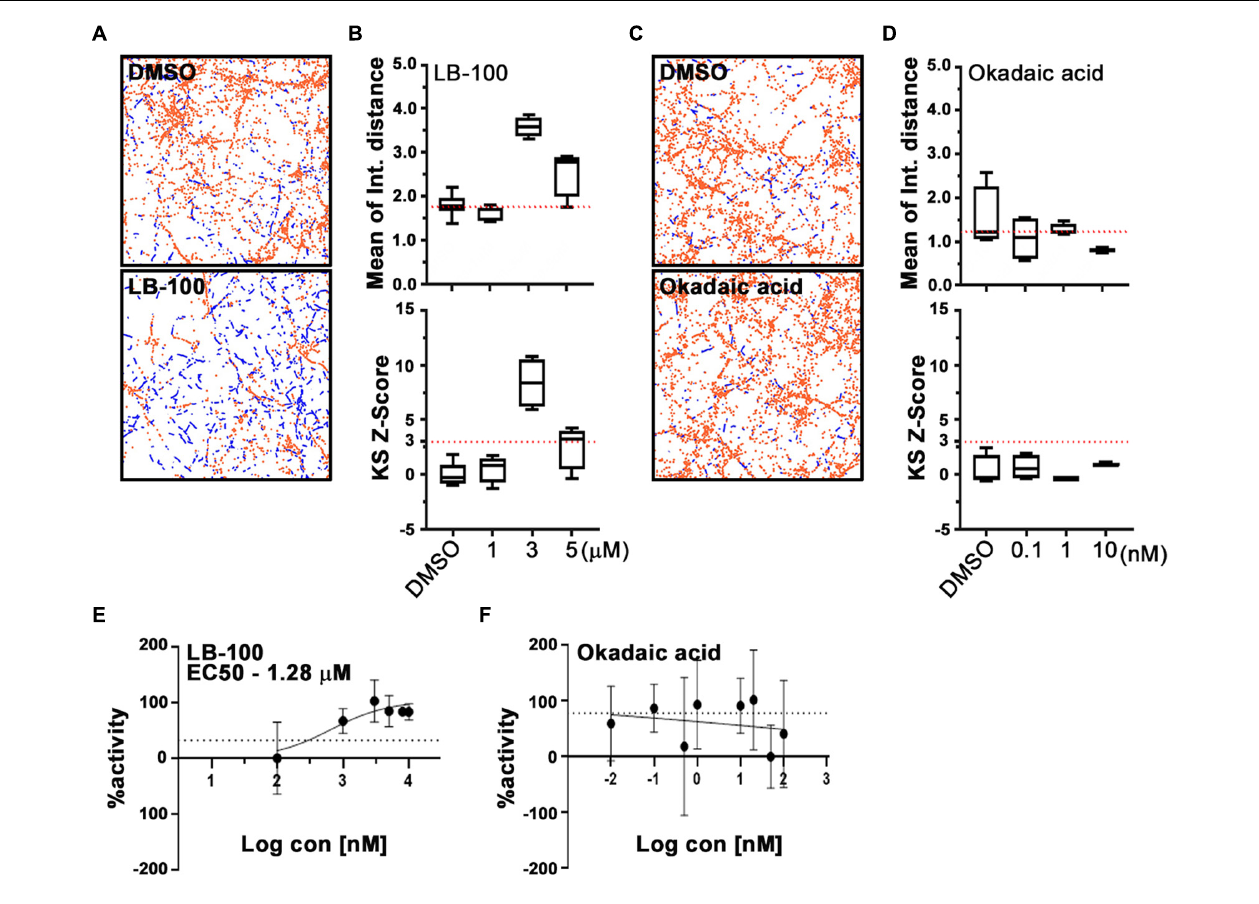
FIGURE 4 | LB-100, but not okadaic acid, enhances mitochondrial movement in cortical neurons. Representative fields (A,C) and quantification (B,D) of mitochondrial movement in neurons treated with LB-100 or okadaic acid and their DMSO controls, as analyzed with PATHS, as in Figure 2 , stationary mitochondria are red and the tracks of moving mitochondria are blue. The mean of integrated distance and KS2 Z -scores of mean of integrated distance were quantified, and dotted lines indicate the average mean integrated distance in DMSO and a Z -score of 3. (E,F) Dose-response curves for LB-100 and okadaic acid plotted as a fraction of maximum activity. Tukey’s box plot was used for all data, and the error bars represent SD. Experiments were done at least in three independent cultures and the mitochondria were imaged in four individual fields per condition in each culture, each field containing dozens of